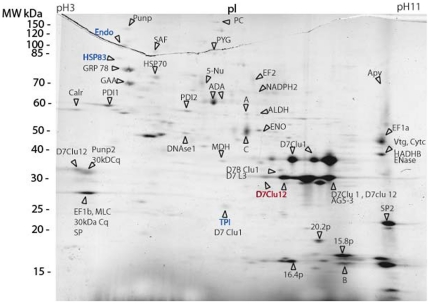
Identification of C. quinquefasciatus salivary proteins by mass spectrometry.Proteins are indicated in a 2D-gels for susceptible and resistant (ace.1R) mosquitoes with spots named according to Table 1. A total of 89 spots were analyzed and a catalogue of 52 salivary proteins is shown. Proteins which are more highly expressed in the resistant (SR) strain than SLAB are coded in blue whereas those under-expressed are coded in red. Spots were excised manually and then digested and extracted with TECAN EVO or manually. Proteins were identified by MALDI-TOF and if the identification was ambiguous, LC-MS/ MS was performed.